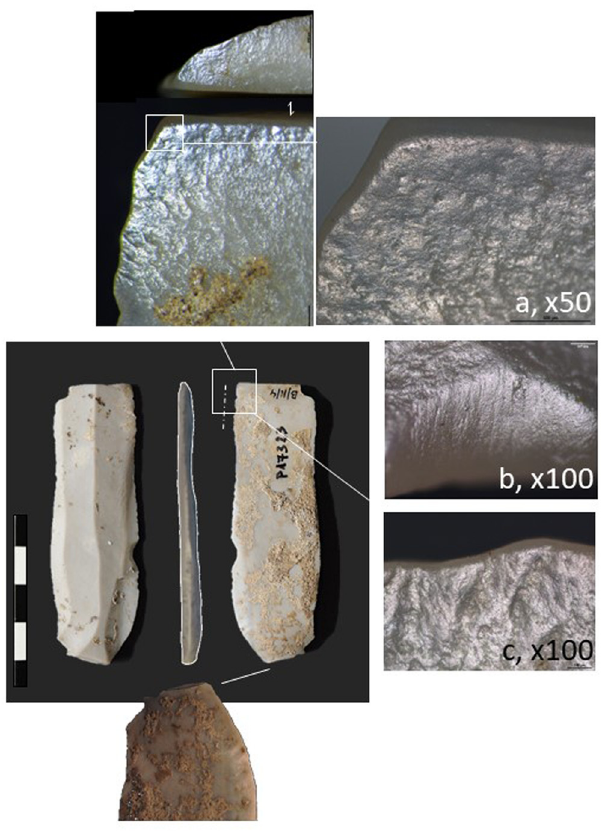
Figure 6: Central Blade ( rhythm B2 ) , slightly hinged, probably obtained by ( lever ) pressure, used to work as a soft mineral material: ( a ) micropolish on the fracture/edge angle; ( b ) non - contact surface, and ( c ) contact